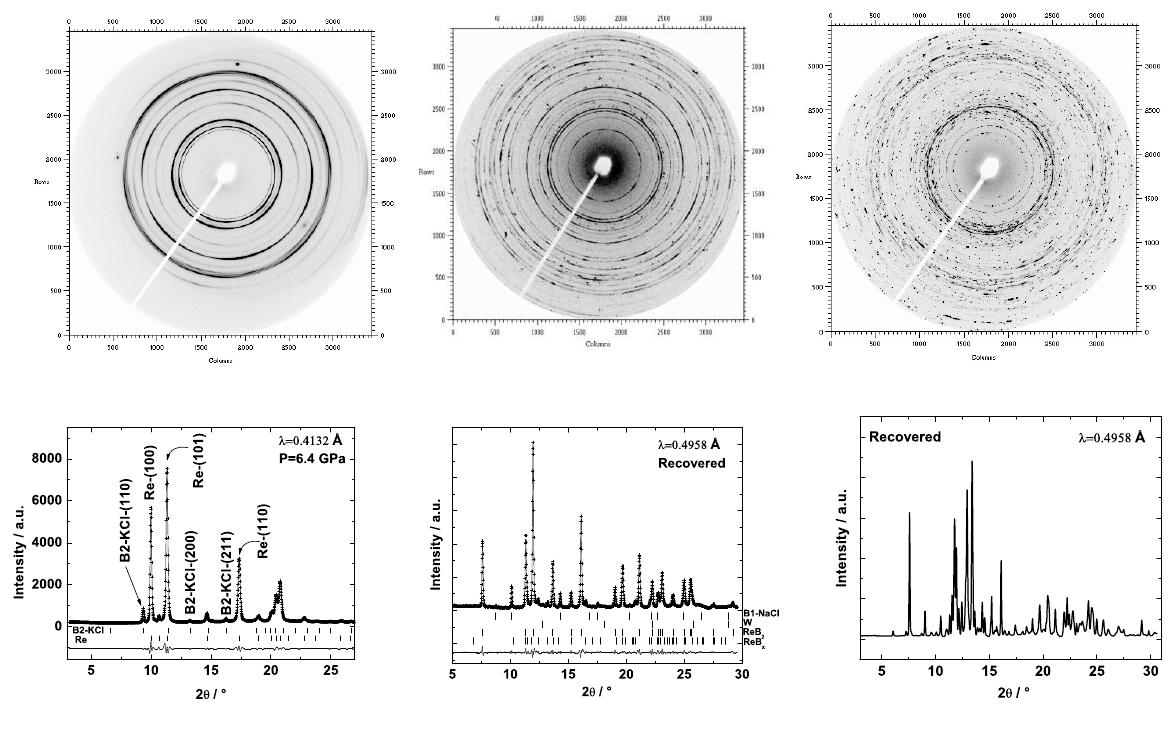
is the bulk modulus and B (cid:48) its 0